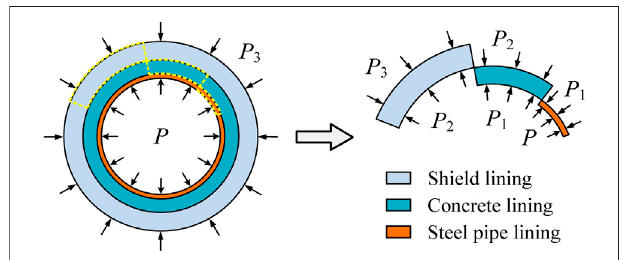
FIGURE 2 | Force analysis model of new composite